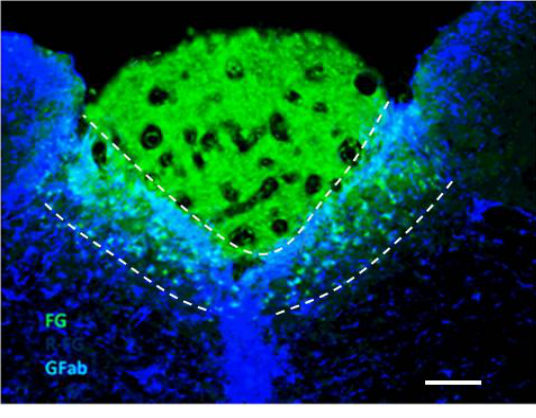
Figure 3. Demonstration of the pNTS with Fluorogold TM . The area between the dashed lines in which both green and blue are seen is the pNTS. Fluorogold TM appears as green in this cross-section of rat brain. Blue is immunostain for glial fibrillar acidic protein (GFAP)-positive astrocytes, which are found in the NTS but not the AP. The green triangular area above the pNTS is the AP, which does not stain blue for astrocytes. The area below the pNTS is surrounding NTS that does not exhibit green for Fluorogold TM . The scale bar at the lower right is 200 microns. Photo and technical description were provided for original use in this article by Linda Rinaman, Ph.D., Department of Neuroscience, University of Pittsburgh.